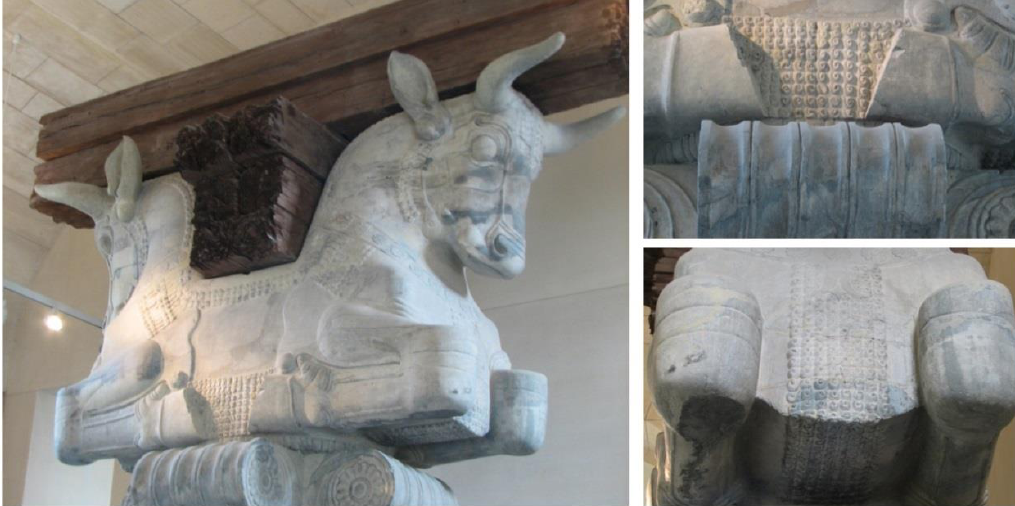
Figure 3. The addorsed bull capitals from the Achaemenid site of Susa. Techniques of construction and architectural forms are identical with those of Persepolis. The similarity of curls carved on the flanks of the bulls and those implemented on their neck is obvious. Source: Louvre Museum, photographed by the author.